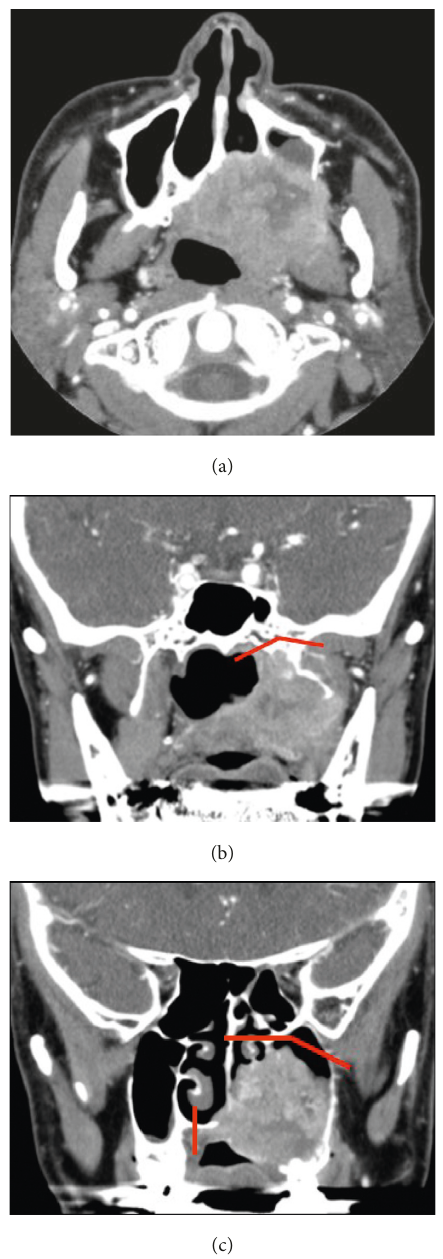
Figure 2: CT views. (a) Axial view: tumor invading the left pos- terior maxillary sinus but not the anterior area. (b) Coronal view: tumor invading the base of the pterygoid process. (c) Tumor not invading the orbital fossa or cranial bone. Red lines are dissection